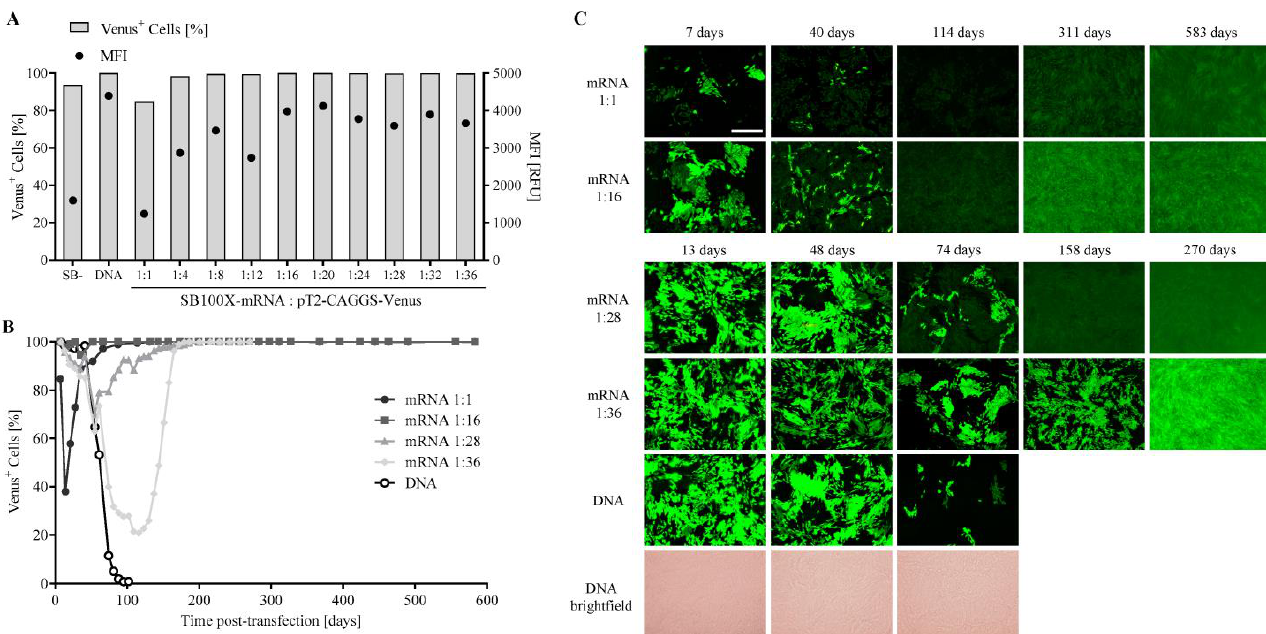
Figure 2. Analysis of transfection efficiency and long-term expression in ARPE-19 cells transfected with pT2-CAGGS-Venus. ARPE-19 cells were transfected with pT2-CAGGS-Venus and SB100X-mRNA at ratios from 1:1 to 1:36 with a total amount of 500 ng nucleic acid. SB100X-DNA served as the positive control, the inactive transposase pSB- as negative control, both at a ratio of 1:28. Cultures were observed regularly and were terminated when the percentage of Venus-positive cells decreased to less than 10%. ( A ) Initial transfection efficiency was determined 1 week after transfection by flow cytometric analysis, measuring the percentage of Venus-positive cells (bars, left axis) and the MFI (dots, right axis). ( B ) Two cell cultures transfected with SB100X-mRNA were monitored for 583 days (ratio of 1:1 and 1:16) and two cultures up to 270 days (ratio 1:28 and 1:36) by flow cytometric analysis, shown is the percentage of Venus-positive cells. ( C ) Fluorescence micrographs of the four long-term cultures show the progression of the cultures from cultures of mixed fluorescence intensity to cultures with similar fluorescence intensity. Note that for the DNA control culture, a reduction in fluorescence was observed. Brightfield micrographs are shown exemplarily for the DNA control culture, indicating the confluent growth of the cultures. Scale bar: 500 μm. The fluorescence analysis of all cultures over the entire observation period can be found in the Supplementary Materials (Figure S1).